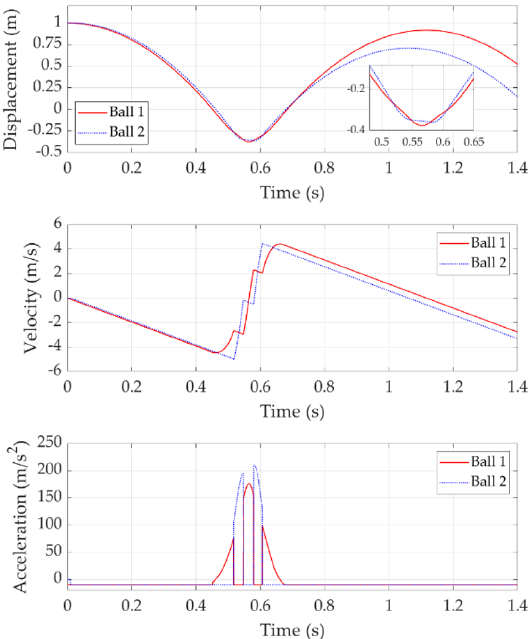
Figure 6. Double bounce with 0.01s release time